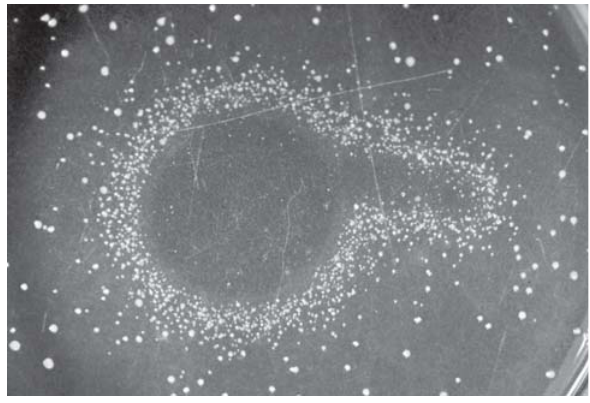
FIGURE 5- Absence of mutagenicity for the calcium hydroxide paste in camphorated paramonochlorophenol